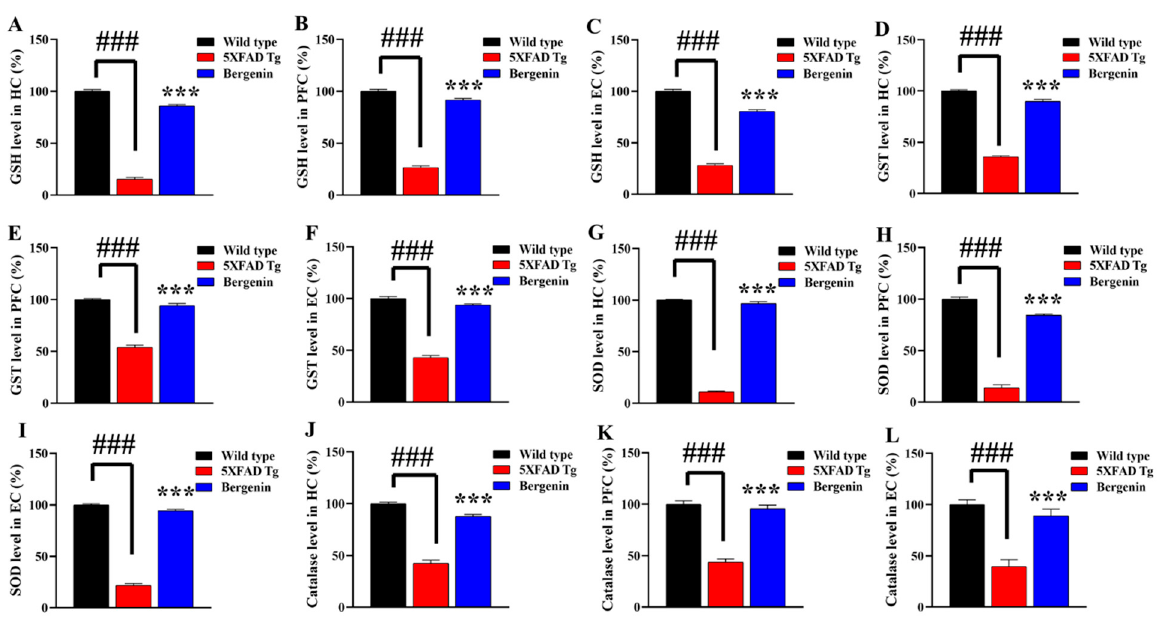
Figure 11. Bergenin (60 mg/kg) enhances antioxidant levels in transgenic mice. Antioxidant proteins and enzymes were determined in the hippocampal (HC), prefrontal cortex (PFC) and entorhinal cortex (EC) regions of mouse brains. ( A – C ) Reduced glutathione (%), ( D – F ) Glutathione-S-transferase (%), ( G – I ) Superoxide dismutase (%) ( J – L ) Catalase (%), level in different regions of mouse brains. Results were expressed as mean ± S.D. *** p < 0.001 versus the 5xFAD Tg mice group, ### p < 0.001 versus the wild type.